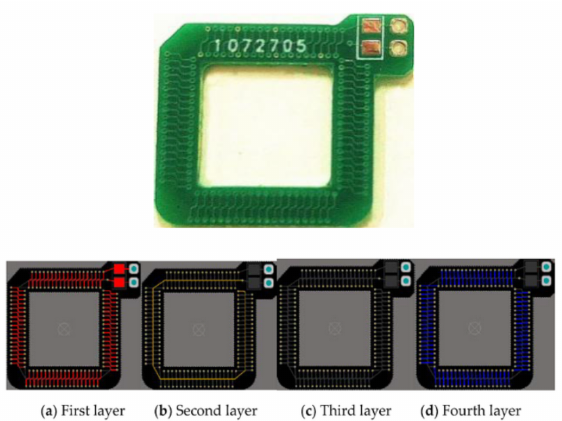
Figure 4. ( Top ) PCB Rogowski coil. ( Bottom ) four-layer board design pattern (reprinted from [51], copyright (2020), Creative Commons